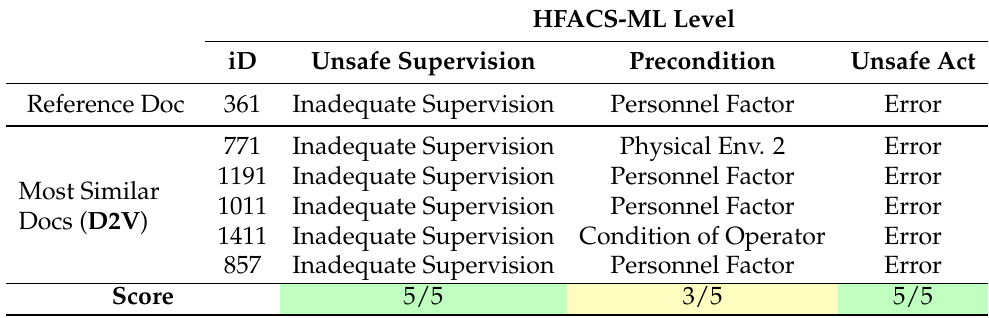
Table 3. Most similar documents, from the Doc2Vec-Distributed Memory (D2V DM)